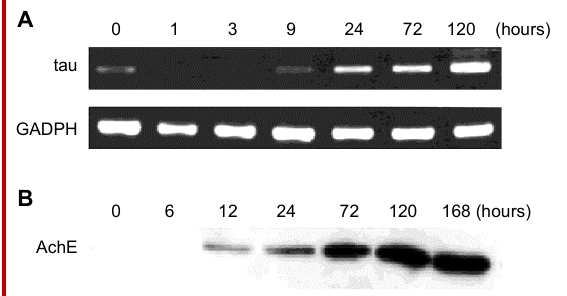
Figure 3: A. The midostaurin treatment effect on the expression of tau mRNA in DU145 cells at various time intervals. B. Time- dependent effect of midostaurin on acetylcholinesterase protein content in DU145 cells